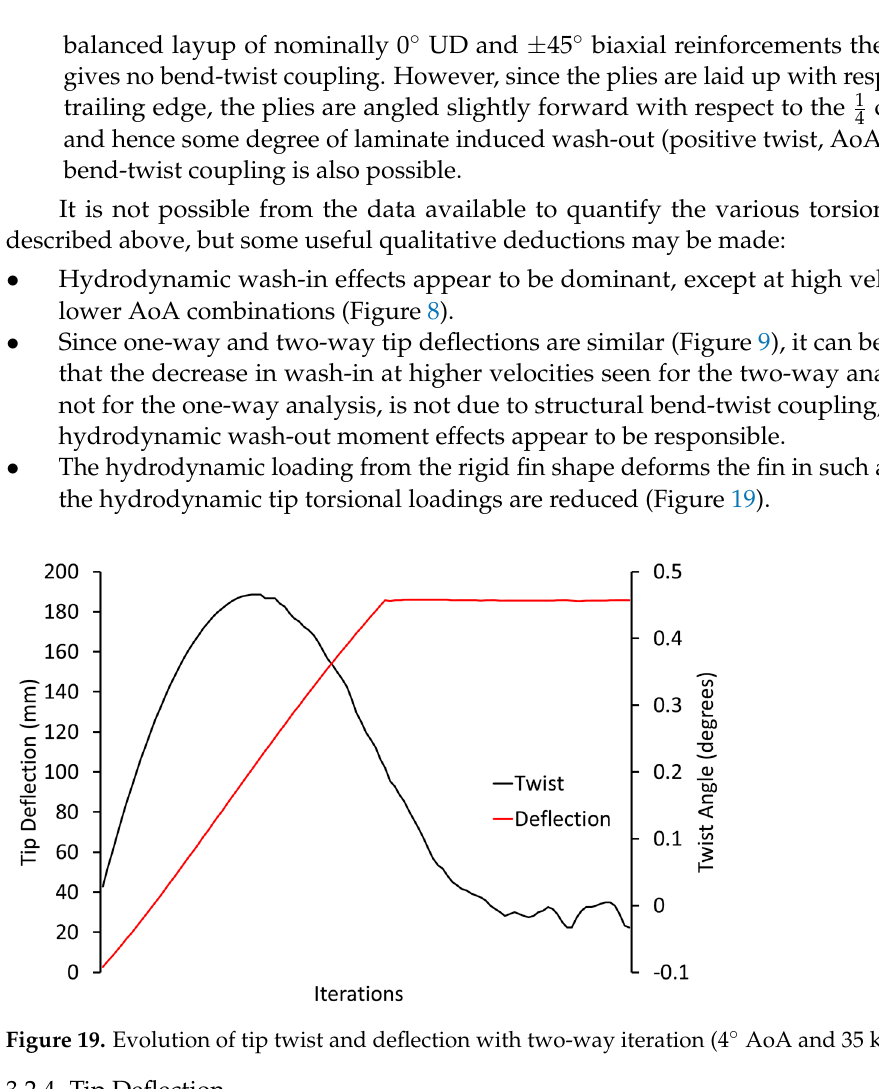
Figure 19. Evolution of tip twist and deflection with two-way iteration (4° AoA and 35 kn).